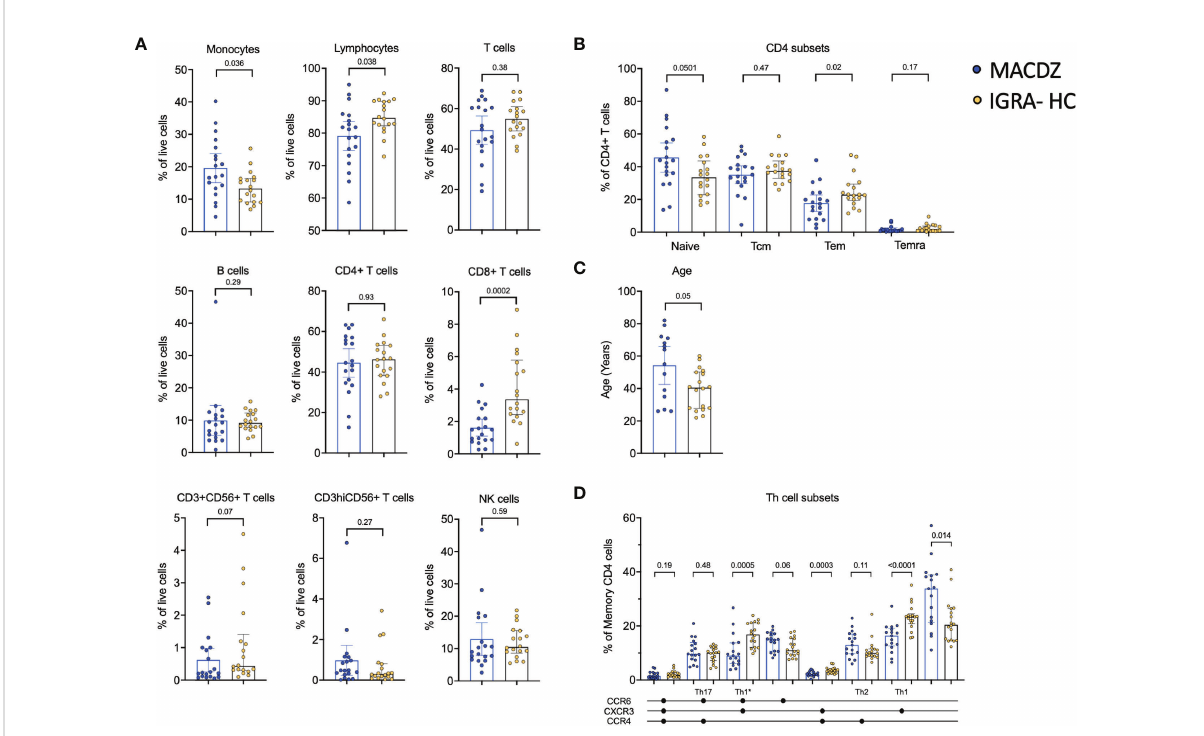
FIGURE 2 Individuals with MAC disease have lower frequencies of speci fi c cell subsets. (A) Frequency of major PBMC subsets in MACDZ (n=19, in blue) and IGRA- HC (n=18, in yellow). (B) Frequency of CD4 memory populations based on CD45RA and CCR7 expression divided in naïve, effector memory (Tem), central memory (Tcm) and Temra populations. (C) Age of the participants. (D) Frequency of Th cell subsets based on CCR4, CCR6 and CXCR3 expression. (A – D) Each point represents one participant, median ± interquartile range is shown. Two-tailed Mann-Whitney